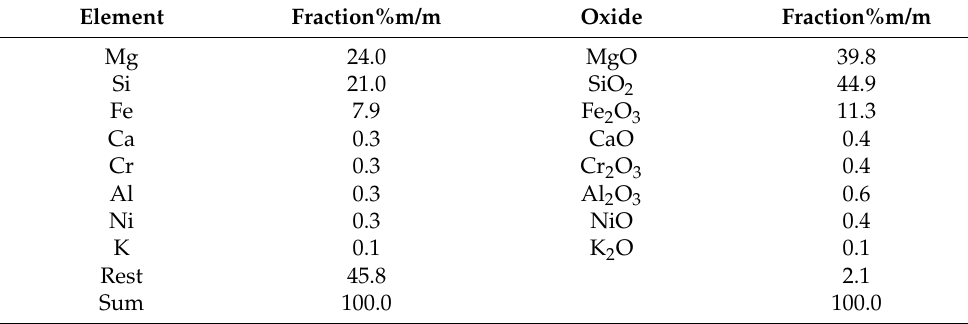
Table 1. Typical chemical analysis of a serpentine sample from the Record Ridge